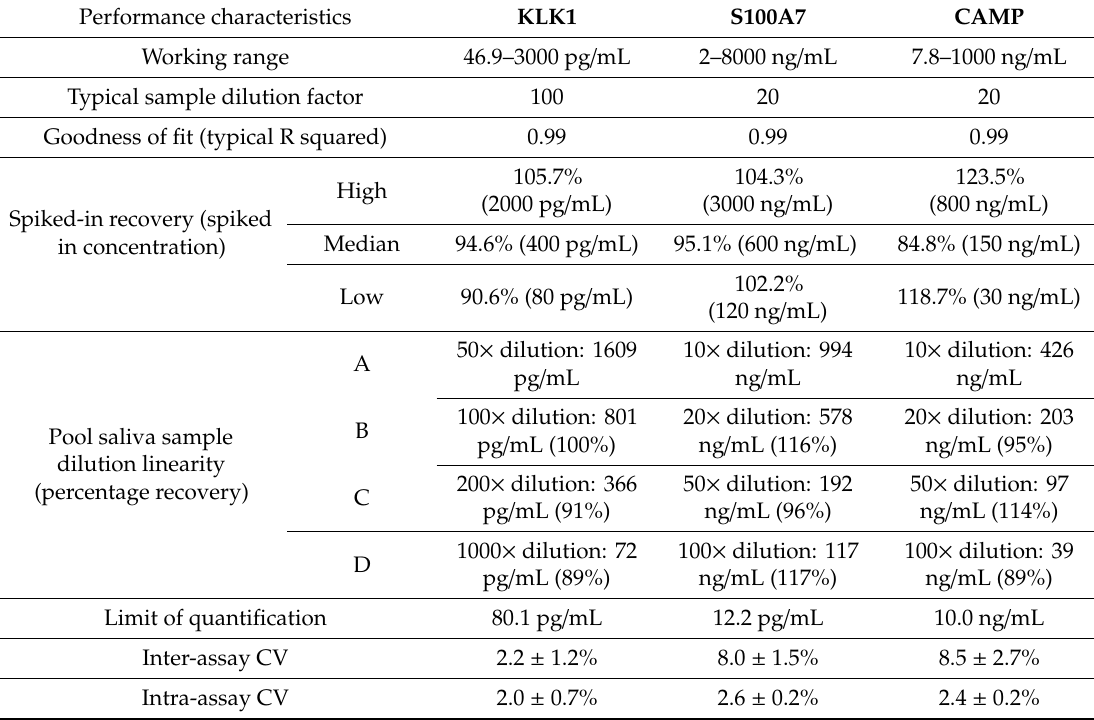
Table 2. Performance characteristics of the in-house developed enzyme-linked immunosorbent assays (ELISAs). Performance